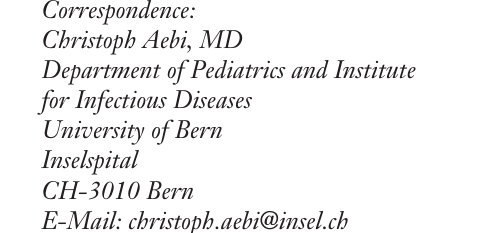
Boxplot presentation of inflammatory markers in 87 chil- dren with adenovirus infection (shaded boxes) and 130 chil- dren with influenza virus infection (open boxes). A, total white blood cell count; B, absolute neutrophil count (ANC); C, ab- solute band count (ABC); D, C-reactive protein (CRP). The boxes define the 25 th , 50 th , and 75 th per- centiles, error bars define the 10 th and 90 th percentile, and dots define individual